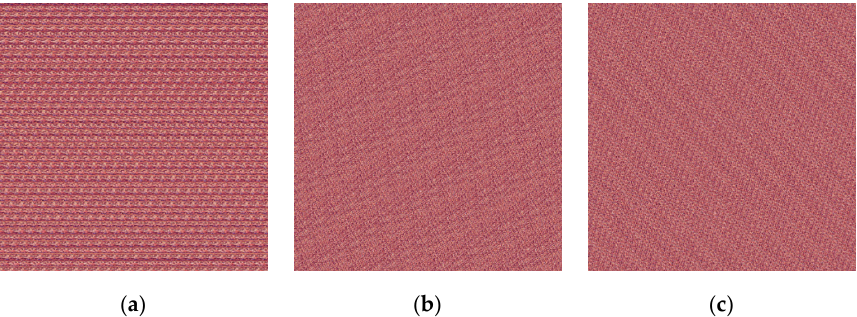
Figure 7. Speech peak frequency is unchanged, and the waveform number is fine-tuned for image decryption. ( a ) Encrypted image when n w 1~ n w 6 are 5, 3, 5, 2, 5, 3; ( b ) Encrypted image when n w 1~ n w 6 are 5, 4, 5, 2, 5, 3; ( c ) Decrypted image that fails after fine-tuning the parameters.